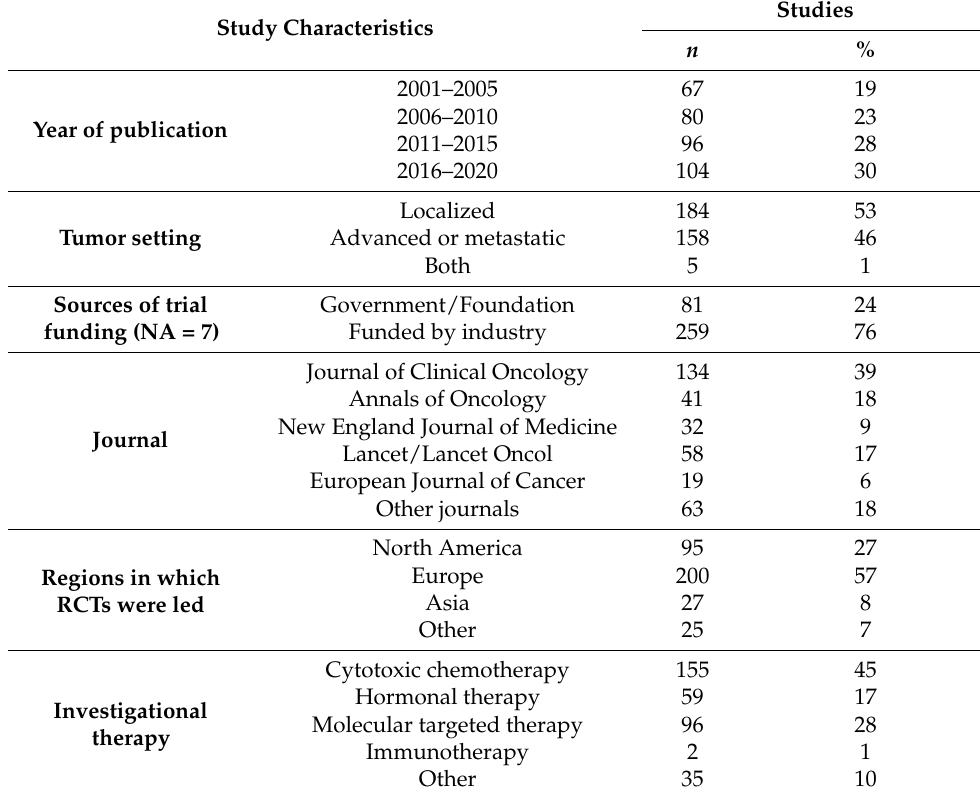
Table 1. Trial characteristics ( n =